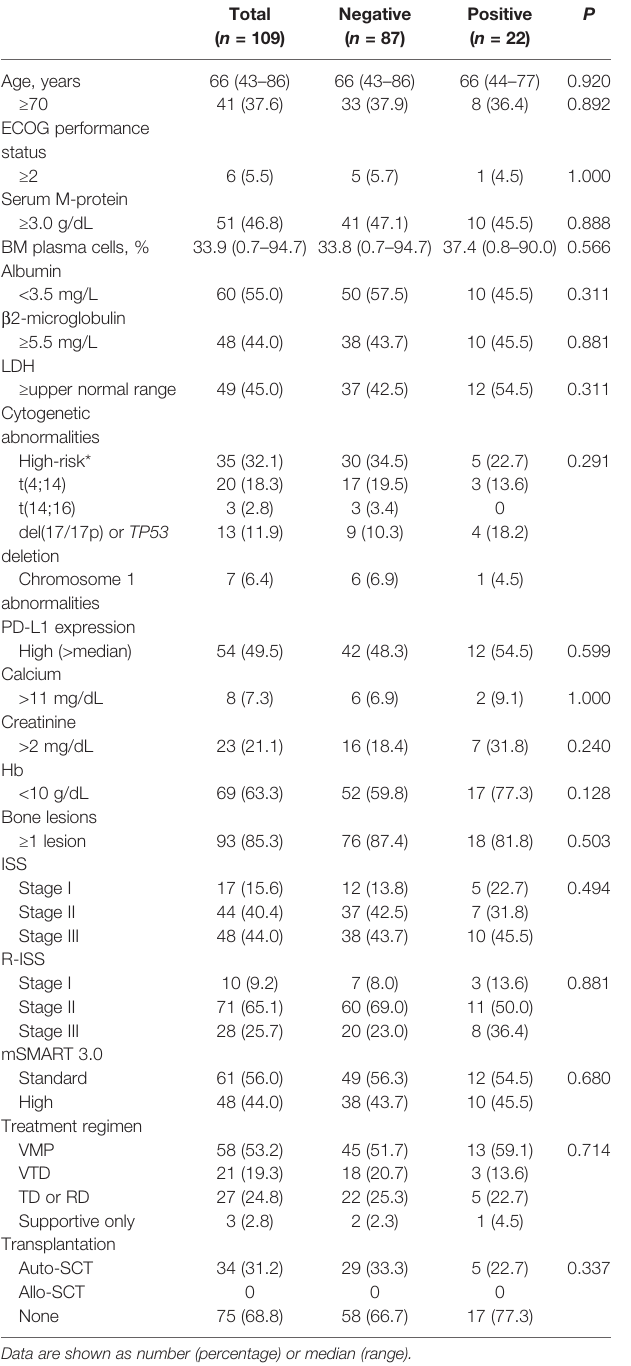
TABLE 2 | Baseline characteristics and clinical parameters according to galectin 9 expression status.